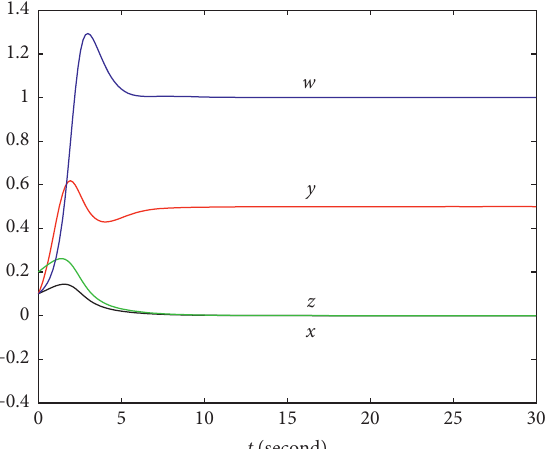
Figure 2: The values a � 0.5, b � 2, c � 0.5, d � 1, e � 1, f � 2, and g � 2 are used. So, we get the stable solution ( x � 0, y � 0.5, z � 0, and w � 1).